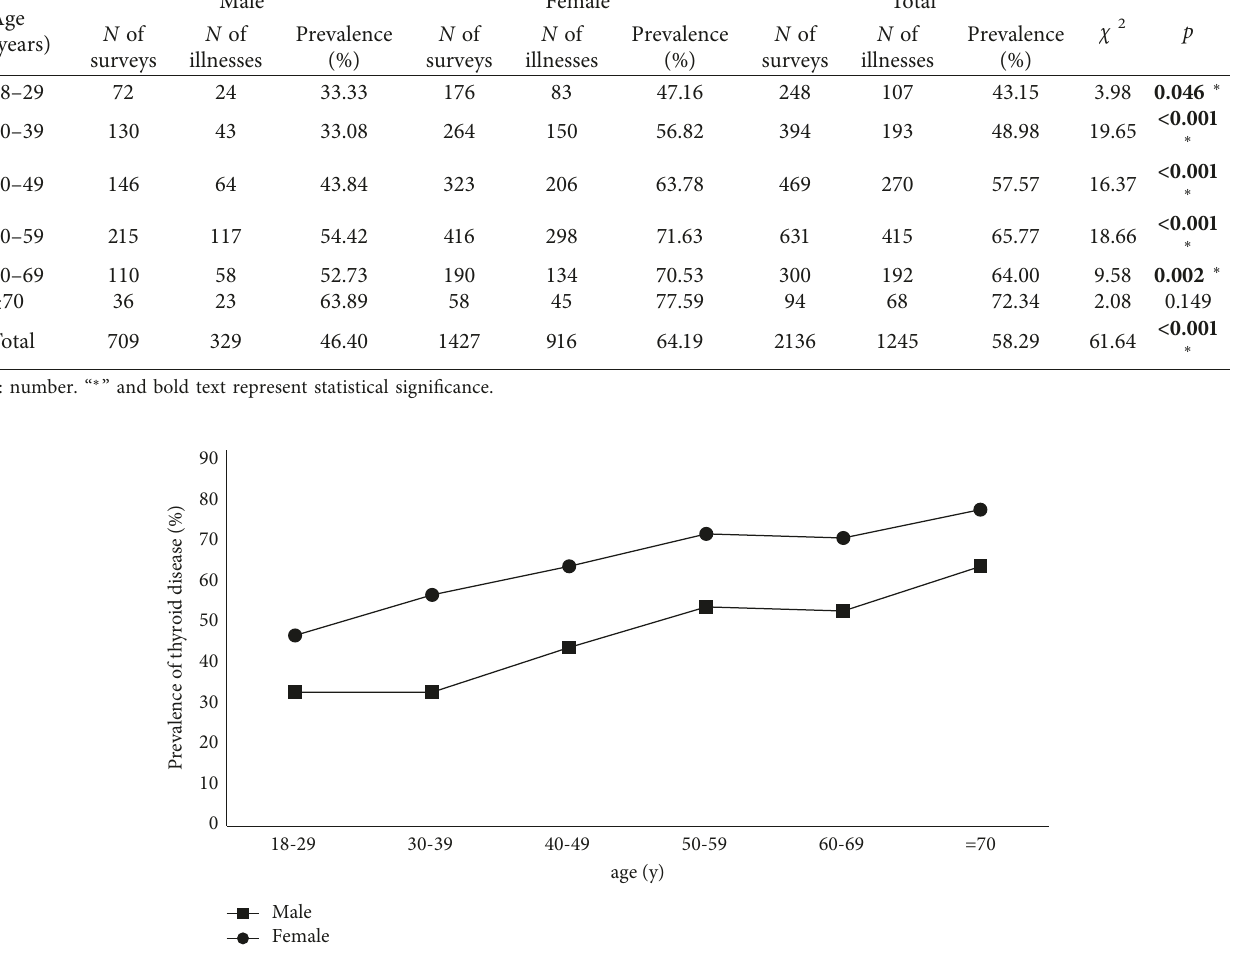
Figure 1: Prevalence of thyroid diseases in different age Table 4: Differences of thyroid prevalence under different obesity parameters.